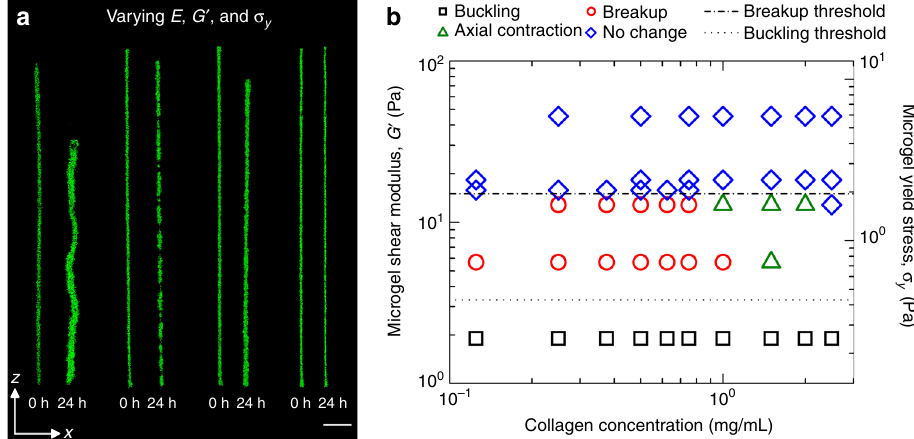
Fig. 4 Microbeam mechanical behaviors controlled by beam and microenvironment material properties. a By varying the shear modulus of the surrounding microgel medium, G ’ , and the beam elastic modulus, E , we observe a cascade of different behaviors; the cell – ECM microbeams buckle, breakup, contract axially, and remain stationary. (left to right: collagen E = 0.035 Pa and microgel G ’ = 1.92 Pa; E = 0.1 Pa, and G ’ = 5.69 Pa; E = 1 Pa and G ’ = 10.85 Pa; E = 0.3 Pa and G ’ = 55.02 Pa. Scale bar: 1 mm). b A two-dimensional map of these behaviors illustrates where transitions occur. Dotted line indicates G ’ b and dashed line indicates σ y f . ( n = 3 samples observed for each displayed data